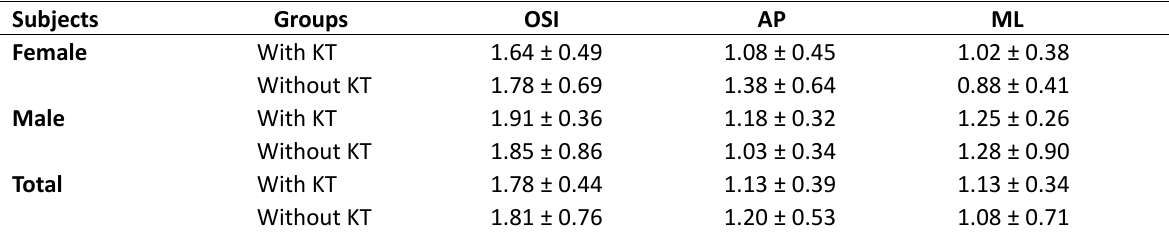
Table 2. Postural control scores with KT and without KT in EO condition (Mean ± SD).